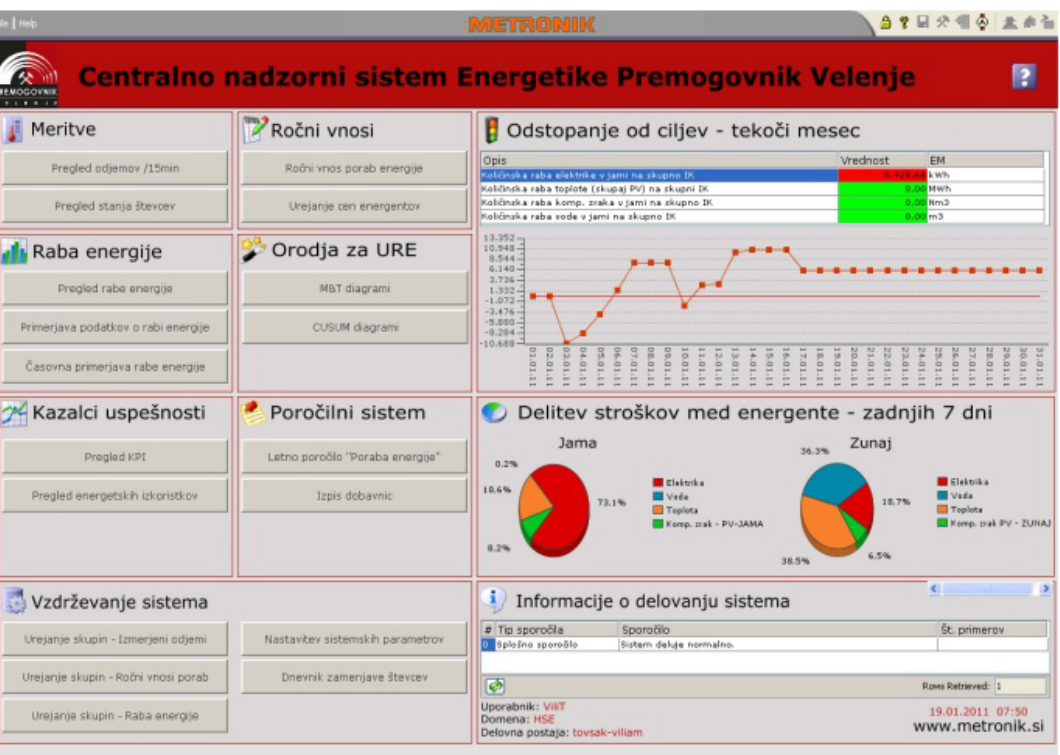
Figure 4. Basic graphical Mepis E&E interface of Velenje Coal Mine’s CSRE